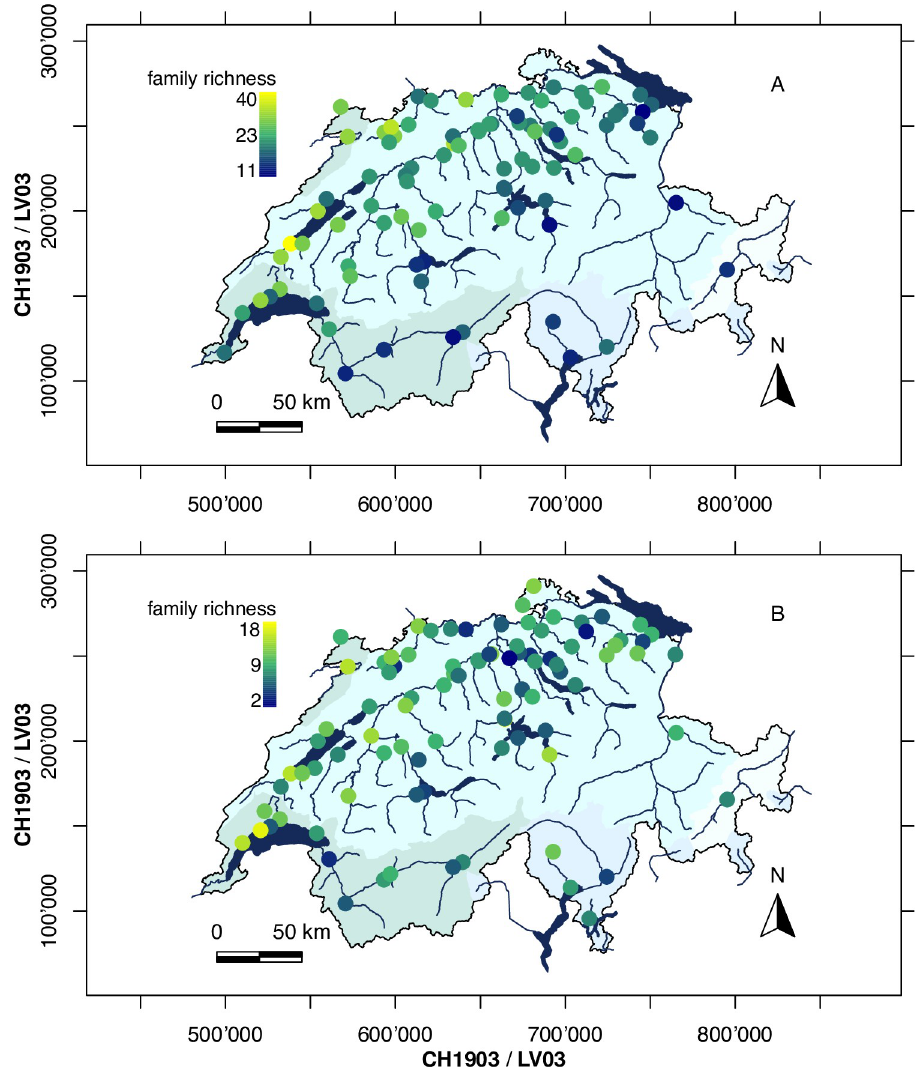
Fig 3. Spatial richness pattern. The taxonomic richness of indicator groups in Swiss rivers at each sampling site based on A) kick-net monitoring and B) eDNA monitoring. For the latter, only macroinvertebrates also considered in the traditional biological assessment are included. The color gradient is adjusted to the respective range of indicator richness